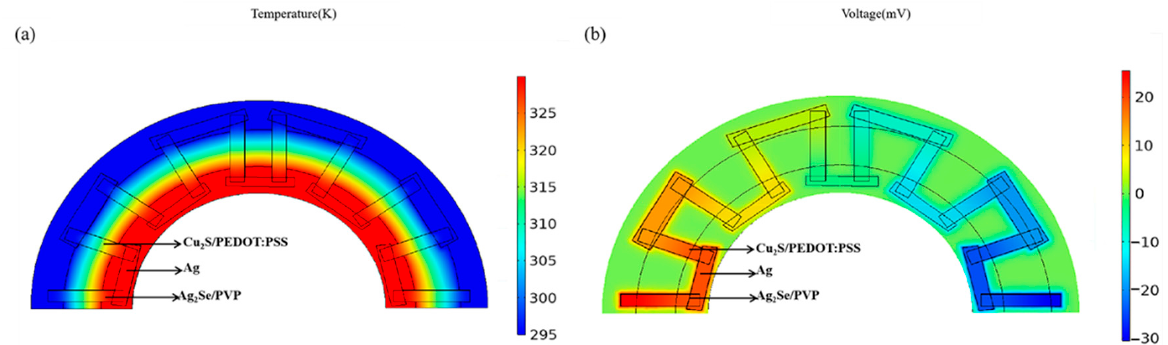
Figure 7. Simulation of f-TEG ( a ) temperature distribution and ( b ) output voltage.